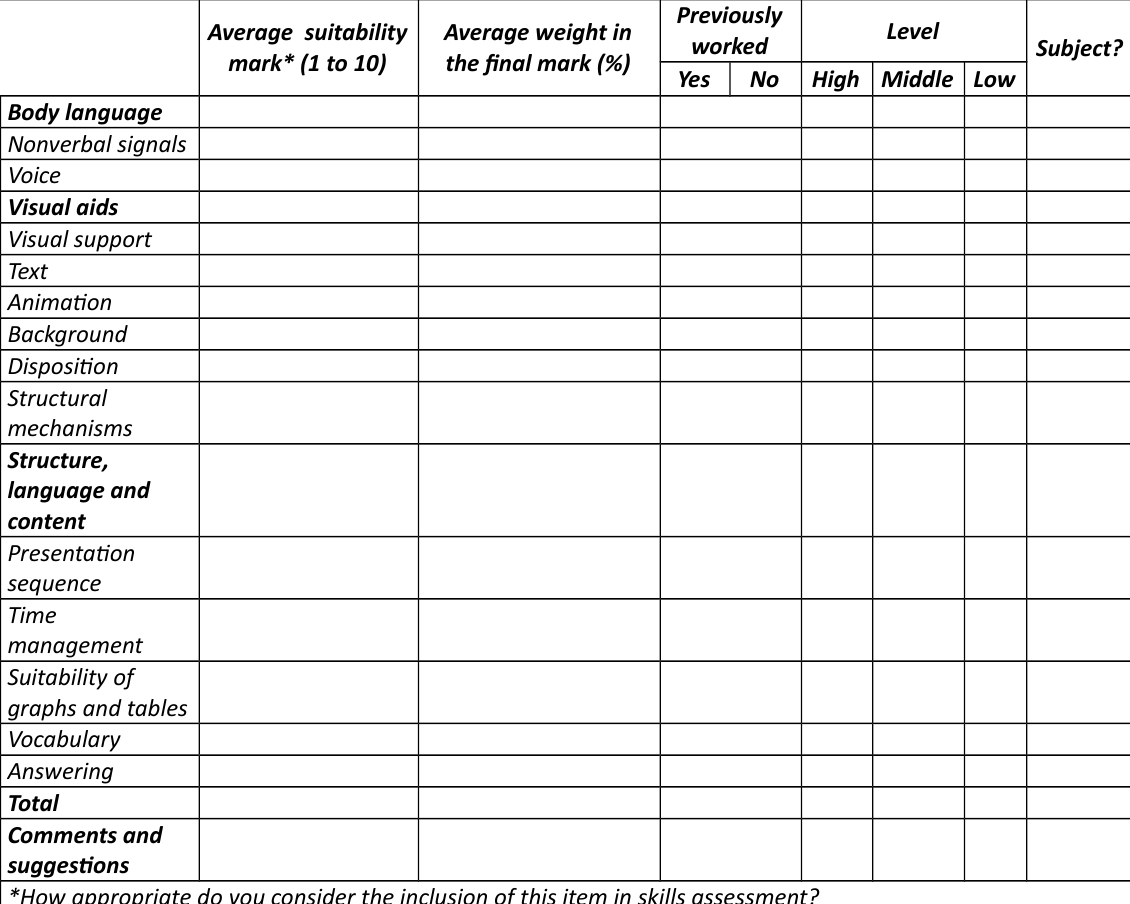
Table 2. Example of rubric validaton